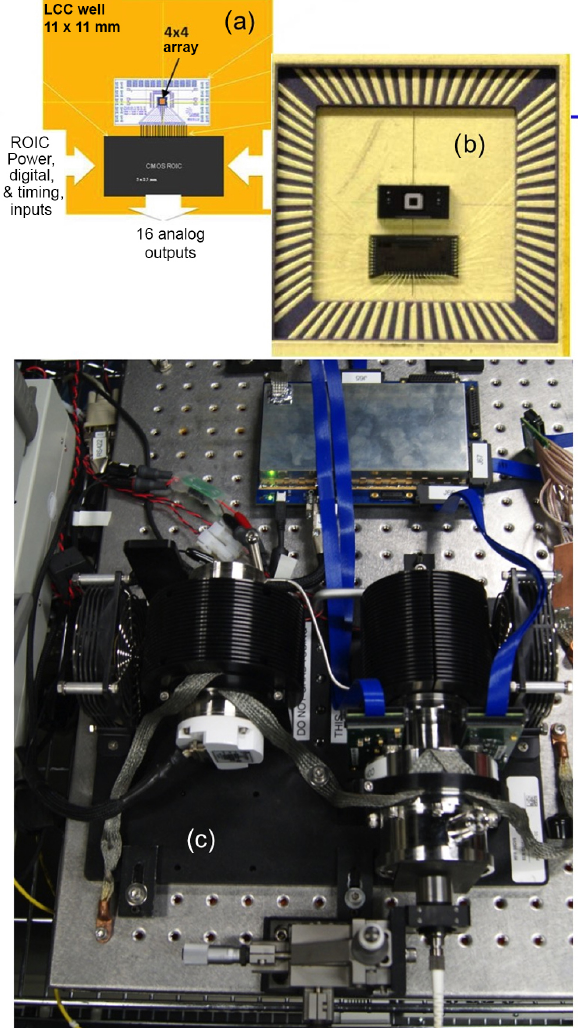
Figure 6. The HgCdTe APD detector used in the lidar receiver. (a) A diagram showing the locations of the 4 × 4 APD detector array and the CMOS preamplifier and readout integrated circuit (ROIC). (b) Photograph of the same elements mounted on the detector’s lead- less chip carrier (LCC). (c) Top view of the detector’s cryo-cooler assembly used to keep the LCC at ∼ 80K. The cooler’s compressor is on the left, the cooled section is on the right, and the fiber optic cable used to couple the optical signal from the telescope through the cryo-cooler’s optical window assembly onto the 4 × 4 detector array is at the bottom. The conditioning and control electronic box is at the top of the